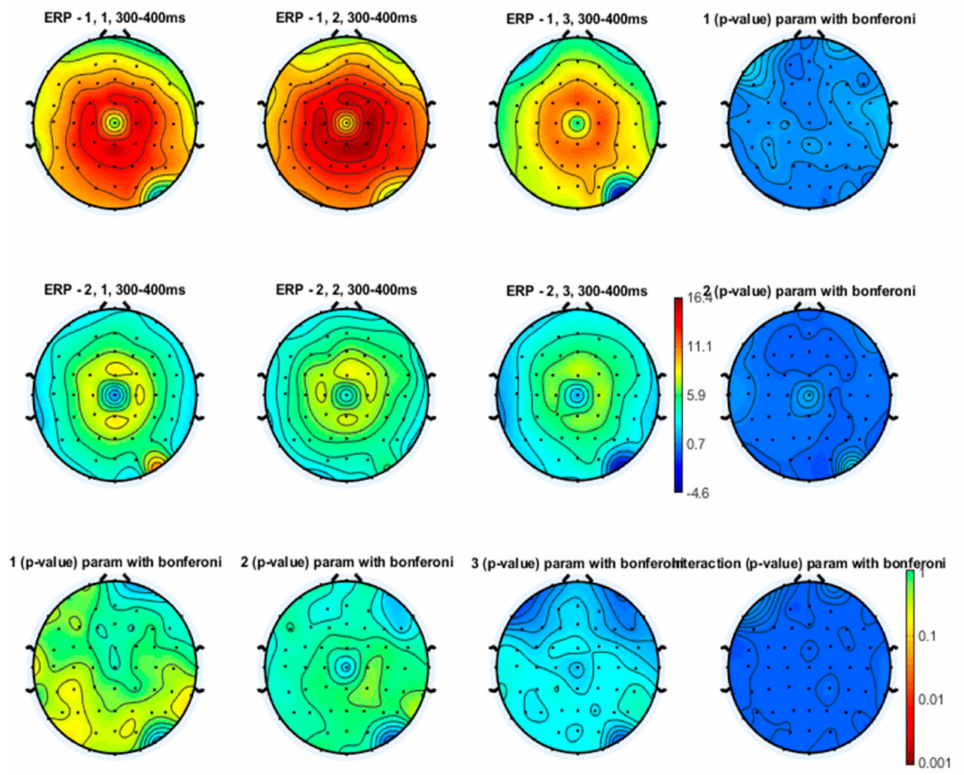
Figure 5. Topographical representation of the P2 component on the right hand stimulation. The first line of topographical maps represents the P2 amplitude in the baseline condition, slow finger tapping (SFT) and fast finger tapping (FFT) in the control group. The second line of maps represents the P2 amplitude in the baseline condition, slow finger tapping (SFT) and fast finger tapping (FFT) in the patient group. The control group’s basal condition (1,1), slow finger tapping (1,2) and fast finger tapping (1,3); the fibromyalgia (FM) group’s basal condition (2,1), slow finger tapping (2,2) and fast finger tapping (2,3) (see also Figure 1). The results of the repeated measures analysis of variance (ANOVA) corrected with the Bonferroni test are